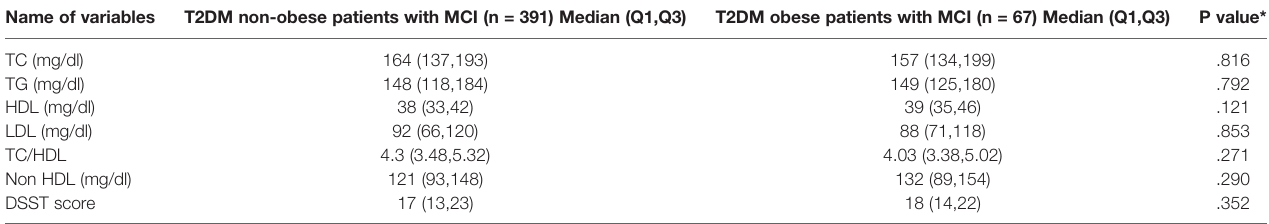
TABLE 5 | Comparison of lipid pro fi le parameters and DSST score in T2DM non-obese and obese patients with MCI.